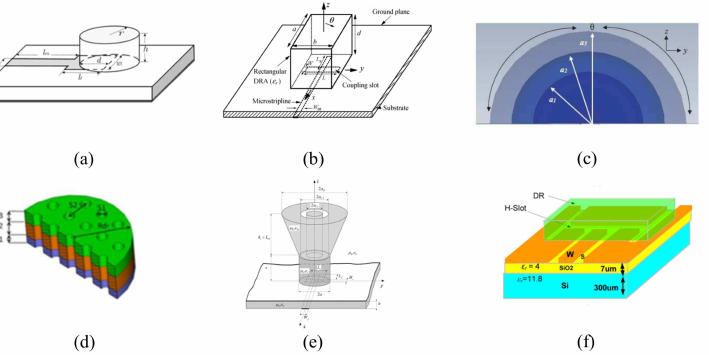
Figure 4. Linear polarization DRA configurations: ( a ) [28]; ( b ) [29]; ( c ) [30]; ( d ) [31]; ( e ) [32]; ( f )